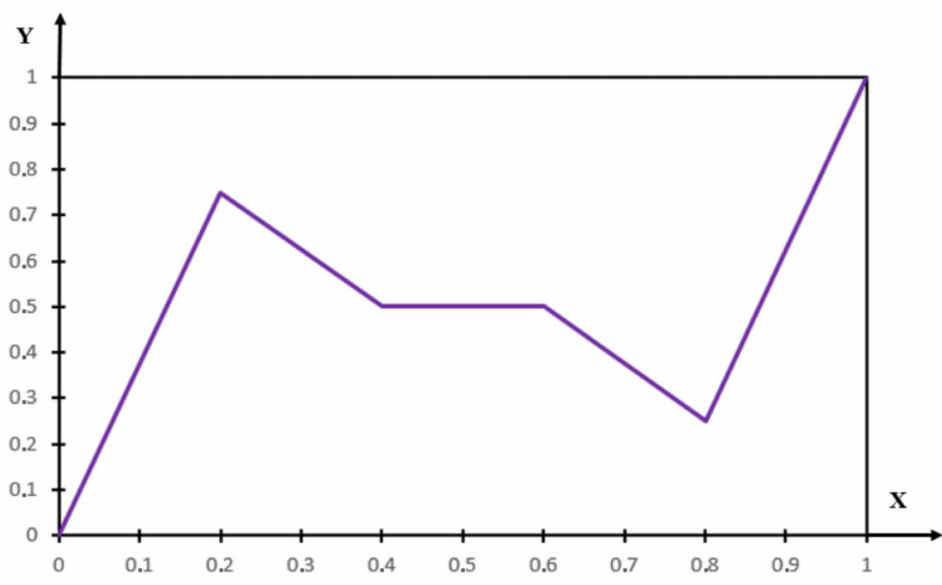
Figure 8. Graph of function F 0 ( x )